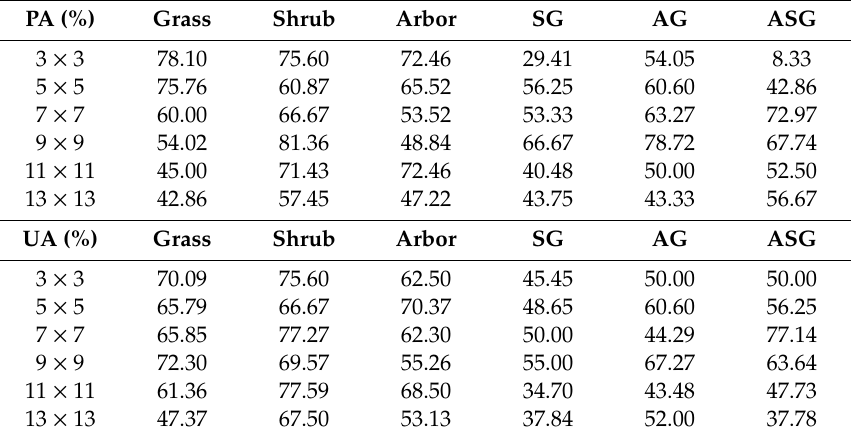
Table 9. The PA and UA of urban vegetation types classification in Shanghai. PA (%) Grass Shrub